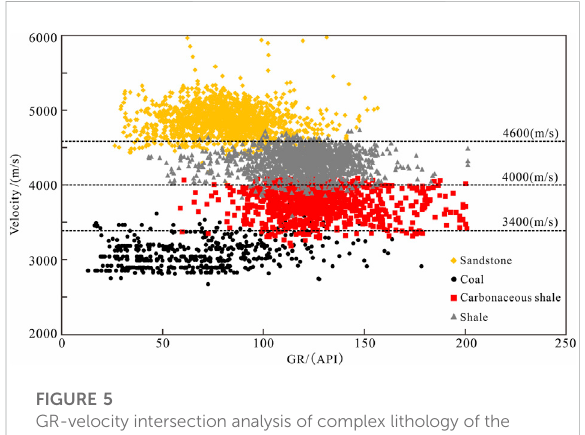
FIGURE 5 GR-velocity intersection analysis of complex lithology of the Shan-2 Lower